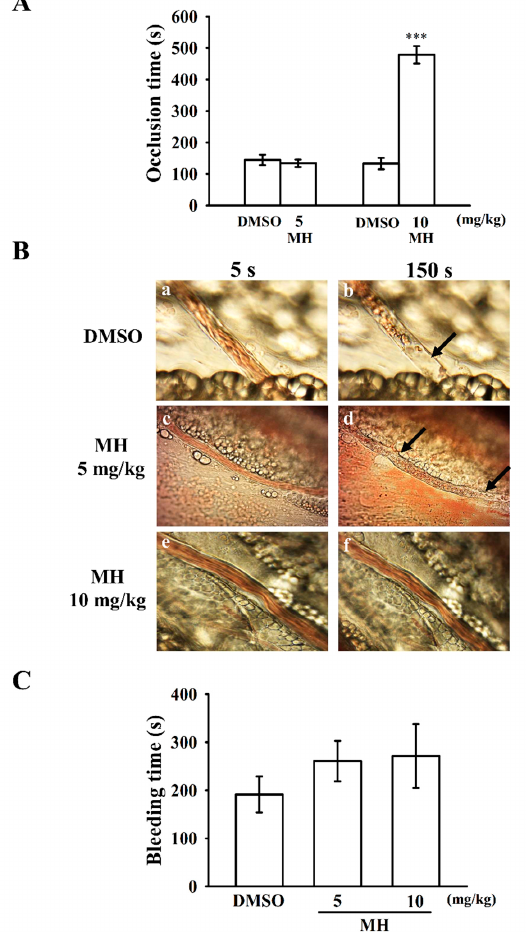
Figure 6. In vivo activities of morin hydrate on thrombotic platelet plug formation in the mesenteric venules and bleeding time in the tail veins of mice. ( A ) Mice were given an intravenous bolus of the solvent control (0.1% DMSO) or morin hydrate (5 and 10 mg/kg) and the mesenteric venules were irradiated to induce microthrombus formation (occlusion time); ( B ) microscopic images (400 × magnification) of 0.1% DMSO-treated controls (a and b); the 5 mg/kg (c and d) and 10 mg/kg (e and f) morin hydrate–treated groups were recorded at 5 s (a, c, and e) and 150 s (b, d, and f) after irradiation. The photographs are representative of six similar experiments. The black arrows indicate platelet plug formation; ( C ) bleeding time was measured through transection of the tail in mice after 30 min of administration of 5 or 10 mg/kg of morin hydrate intraperitoneally. Data are presented as means ± standard errors of means ( A – C , n = 6). *** p < 0.001 compared with the 0.1% DMSO-treated